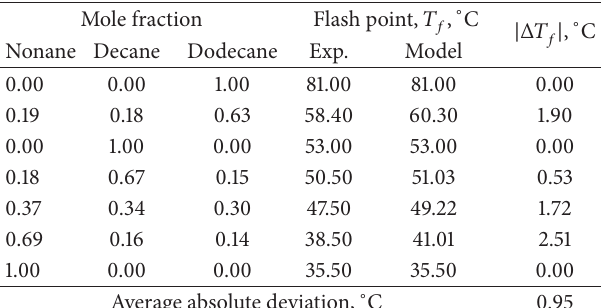
Table 10: Flash point of nonane + decane + dodecane with different mole fractions. Mole fraction